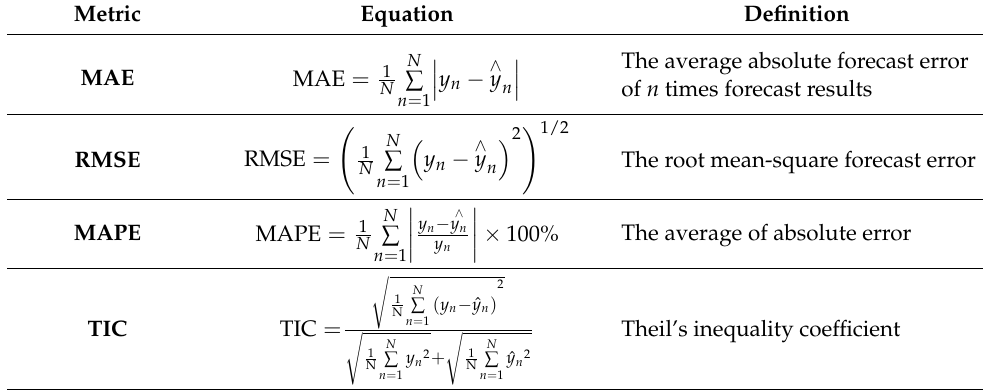
Table 1. Four evaluation